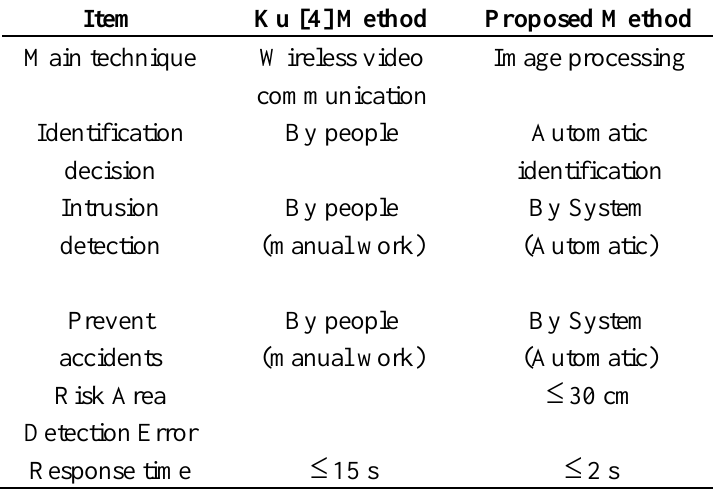
Table 7. Function comparison table between the Ku [4] and proposed